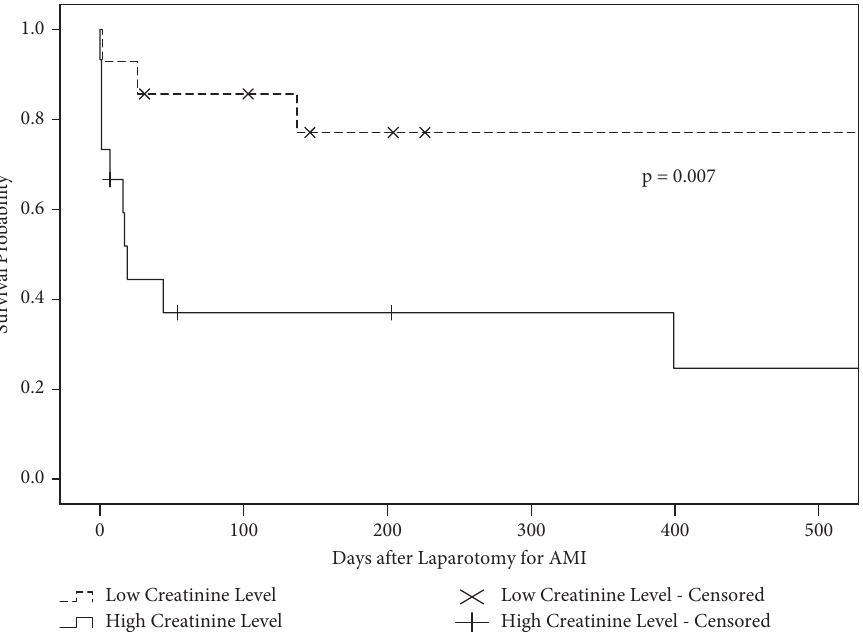
Figure 2: Survival probabilities in patients with a high creatinine level ( ≥ 1.59 mg/dL, n � 15) (solid line) and those with a low creatinine level ( < 1.59 mg/dL, n � 14) (dotted line) after laparotomy for acute mesenteric ischemia following cardiovascular surgery. The plus and cross marks represent censoring in patients with high and low creatinine levels,